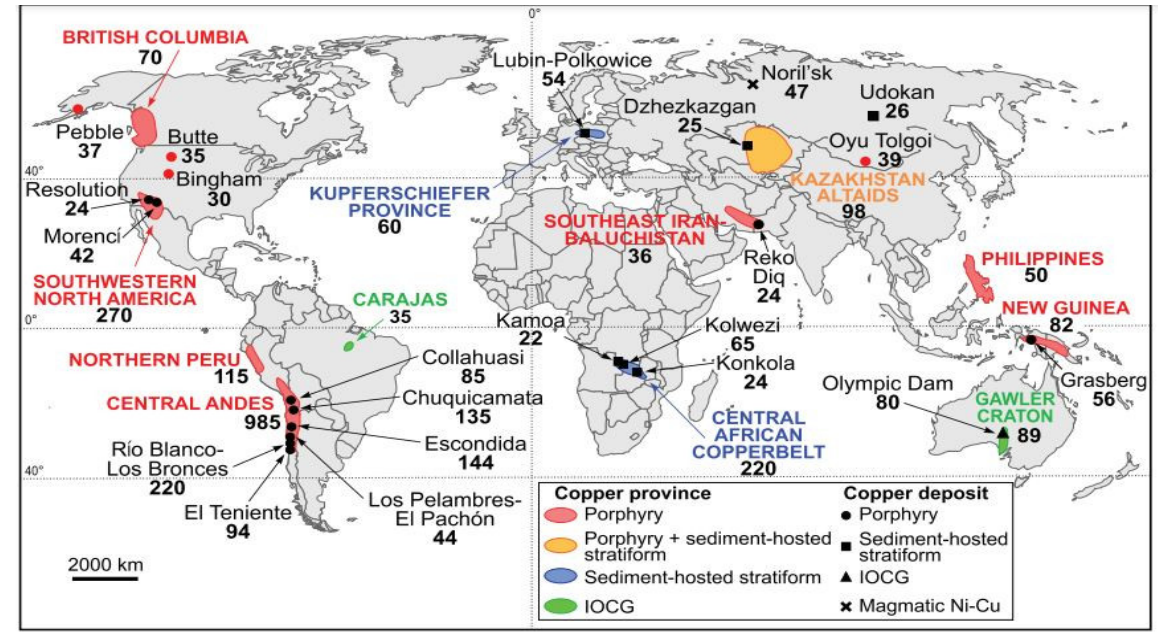
Figure 7. World map depicting important copper deposit [34]. Table 2. Types of major copper deposits [11,33,35,36].